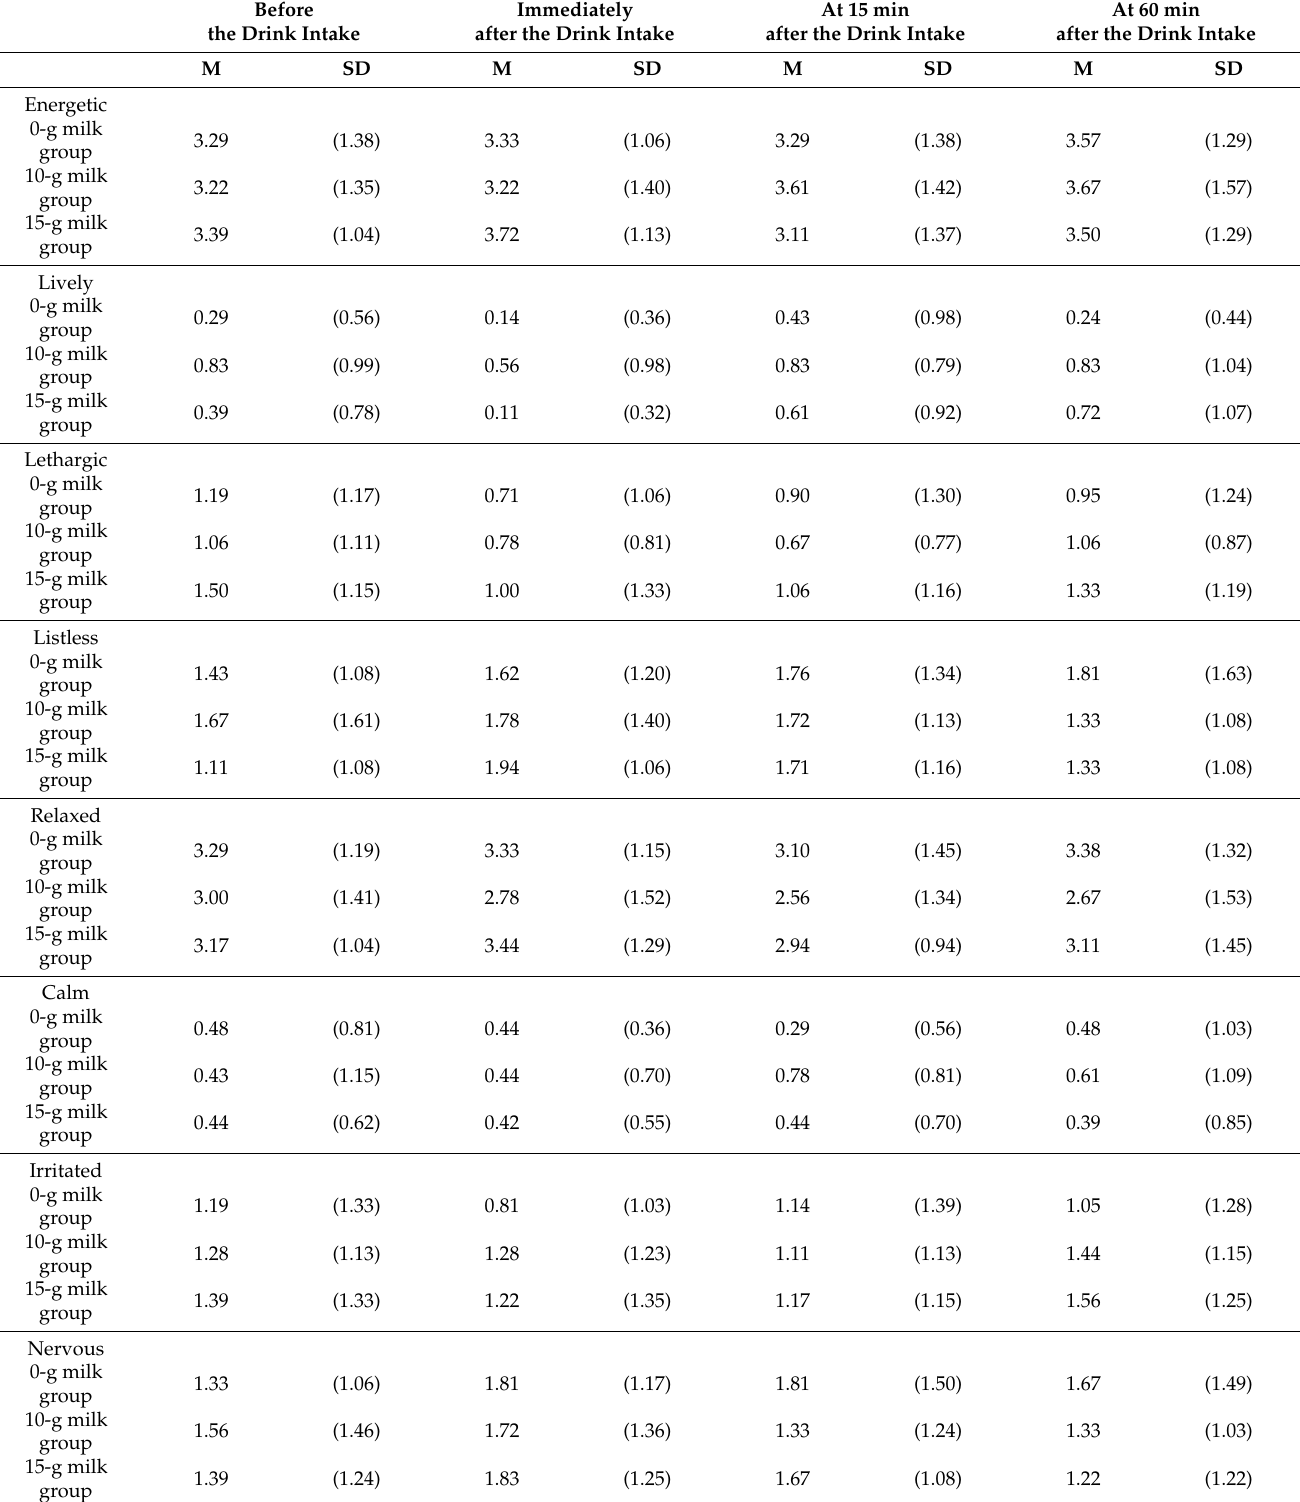
Table 8. Two-dimensional mood scale scores before and 15 and 60 min after drink